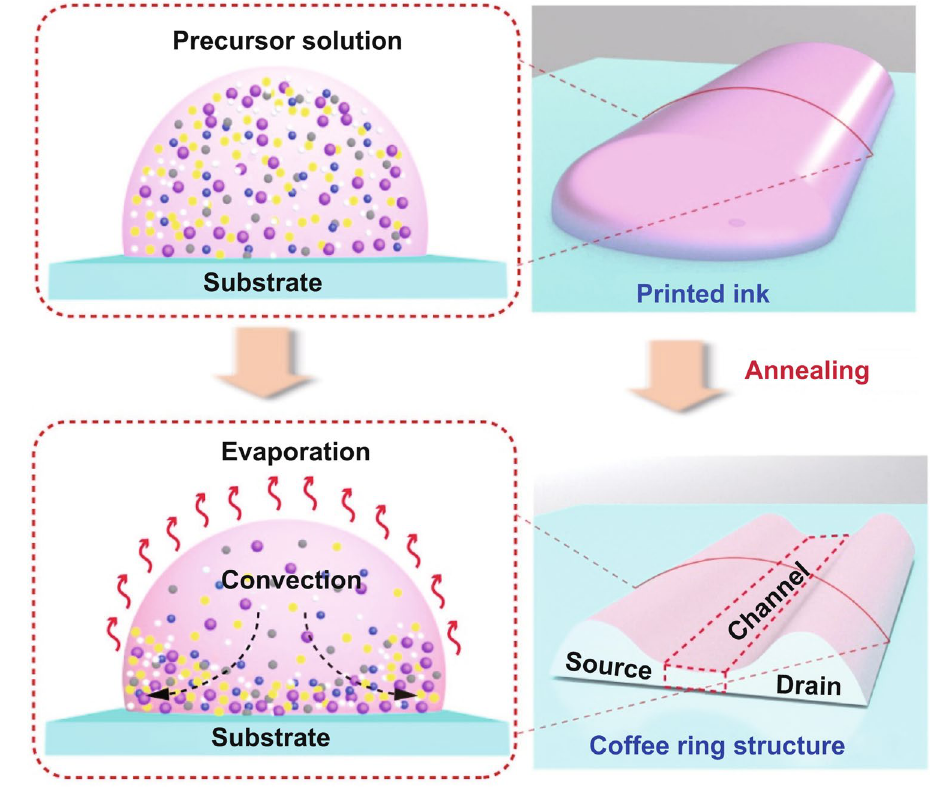
Fig. 1 Schematic illustration showing the formation process of the coffee-ring structure. During annealing process, the solute moved to the edges due to capillary flow, forming coffee-ring